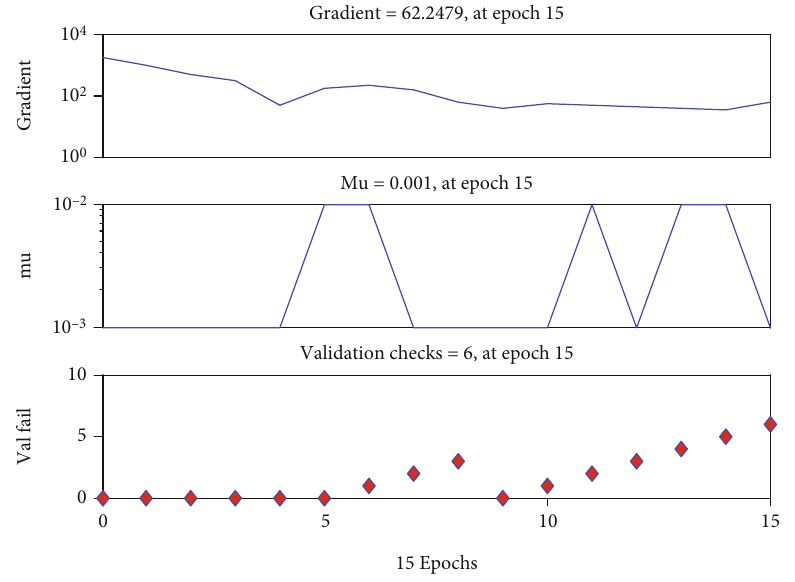
Figure 5: Fitness during training state of proposed method during